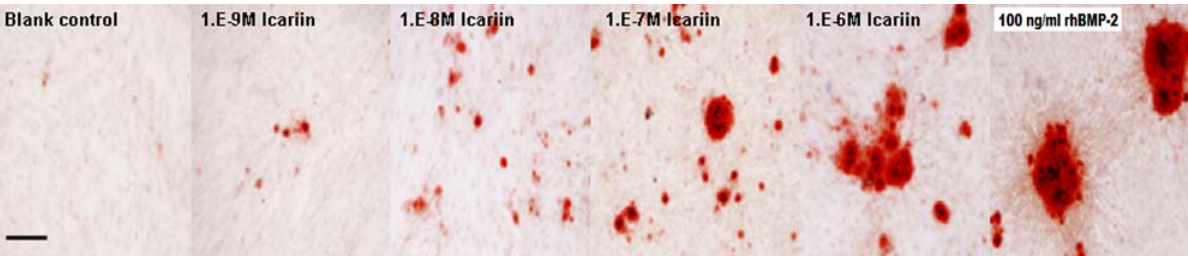
Figure 7. The observation of mineralized deposits (bar indicates 100 μ m)